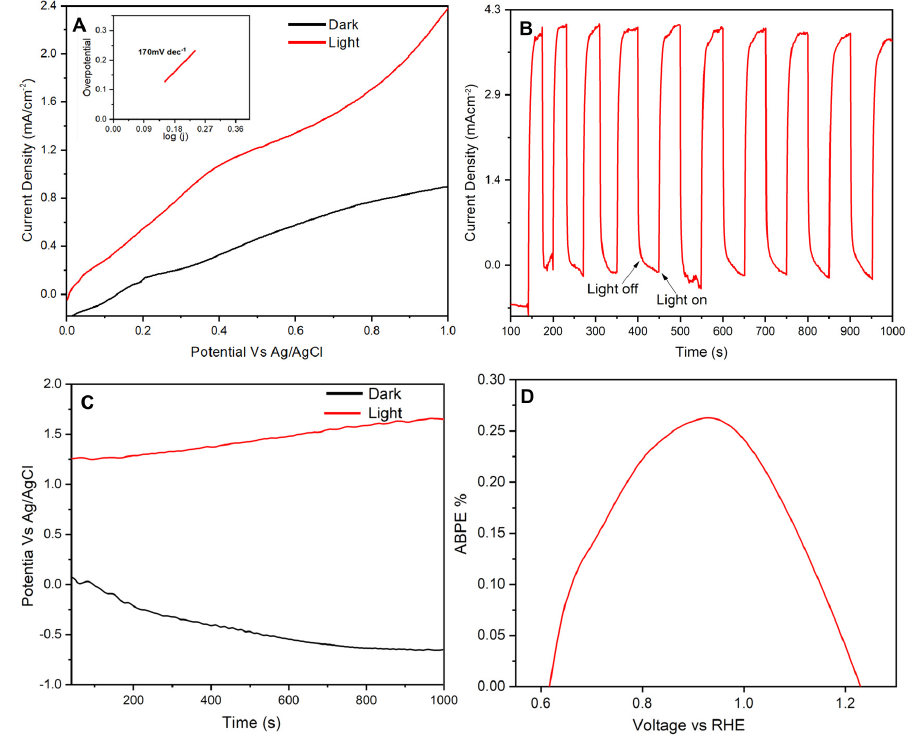
Figure 6. ( A ) LSV scan in the presence and absence of light (inset is the Tafel slope); ( B ) CA chopping at 0.5 V; ( C ) stability; ( D ) photocatalyst efficiency. at 0.5 V; ( C ) stability; ( D ) photocatalyst